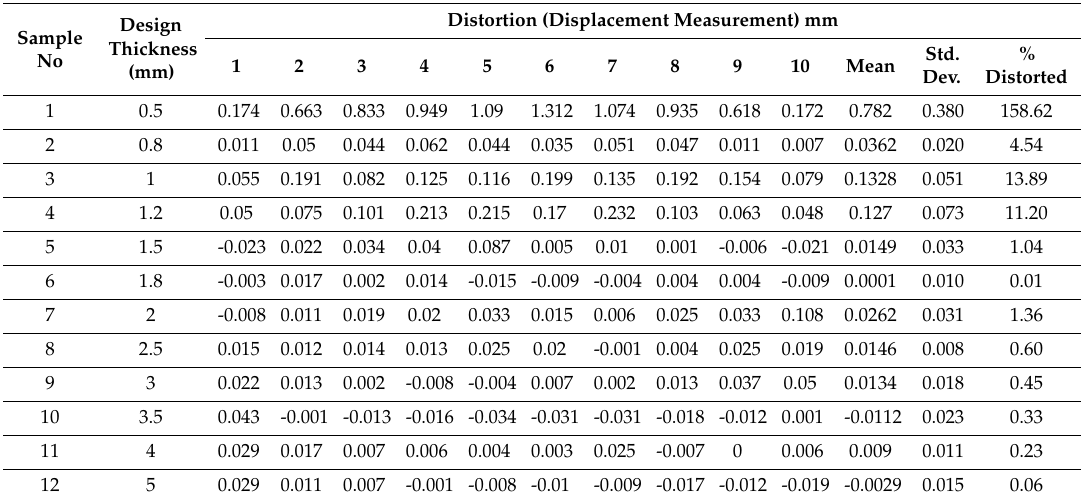
Table 4. Distortion measurement results of the thickness of